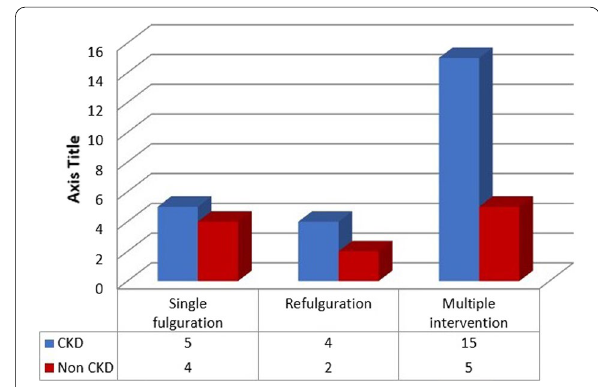
Fig. 1 Relation between number of interventions and progression to